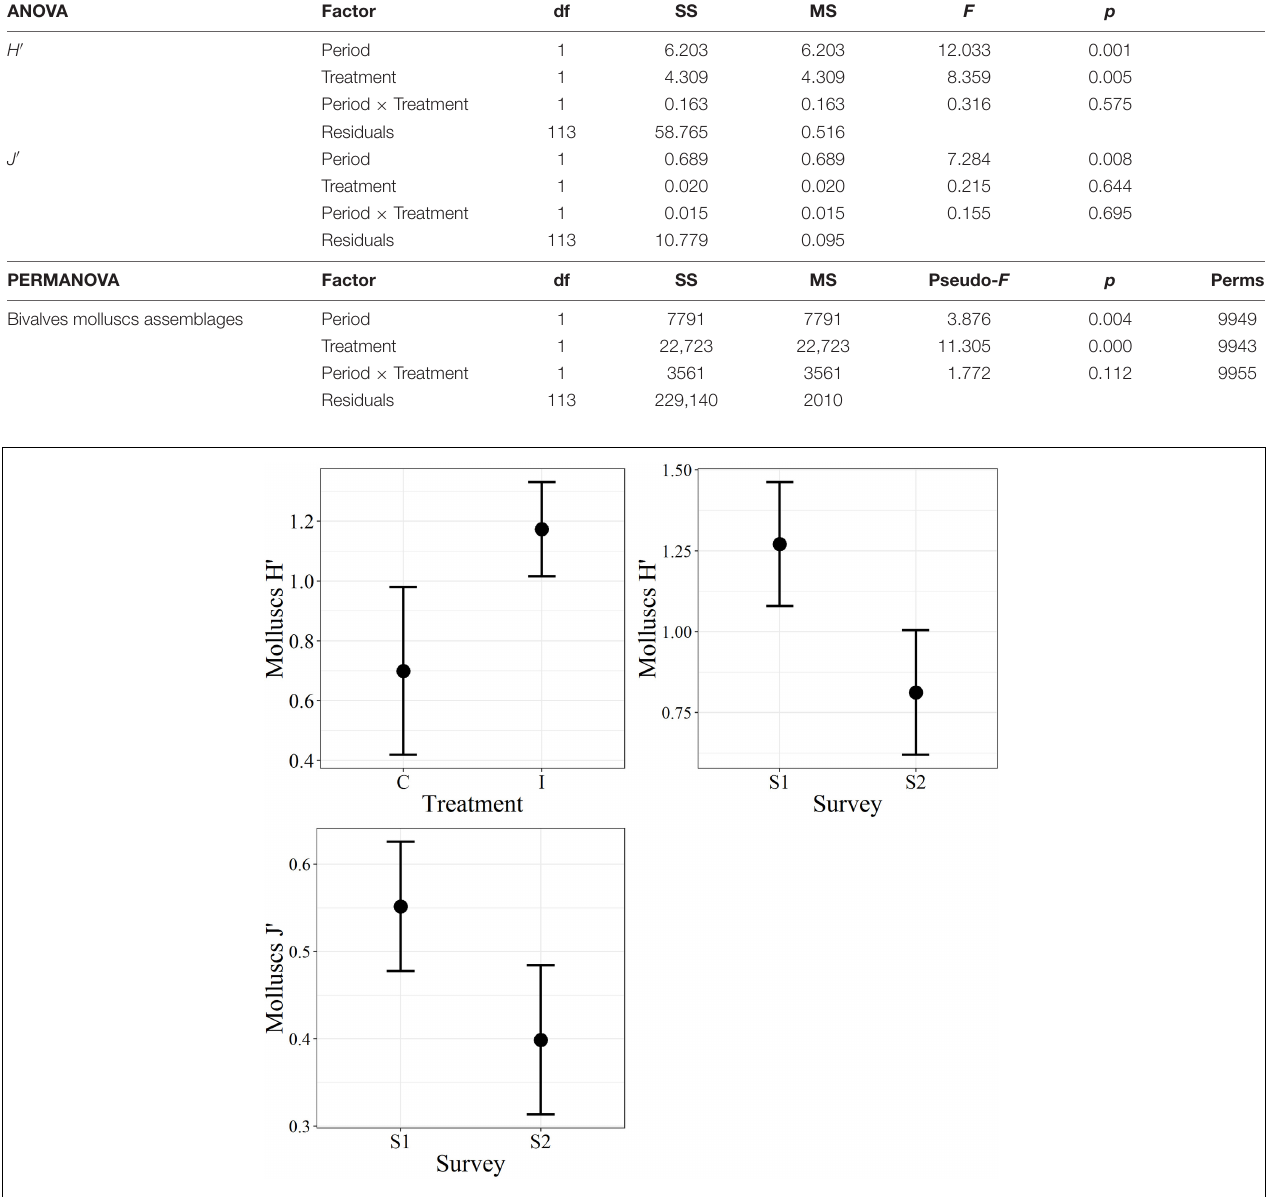
FIGURE 4 | The Plot of the molluscs biodiversity indices. H (cid:48) , Shannon–Wiener diversity index; J (cid:48) , Pielou’s evenness; C, control; I, impact; S1, first survey; S2, second survey. The bars represent the 95% confidence intervals.